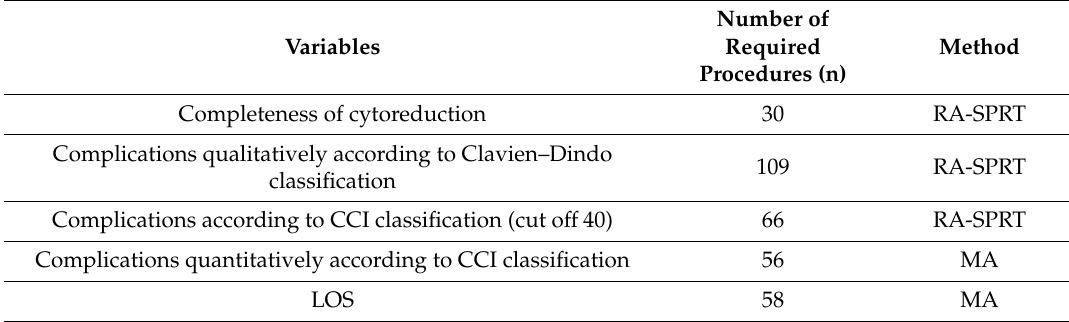
Table 5. The number of required procedures necessary to accomplish the learning curve (LC) using various outcome